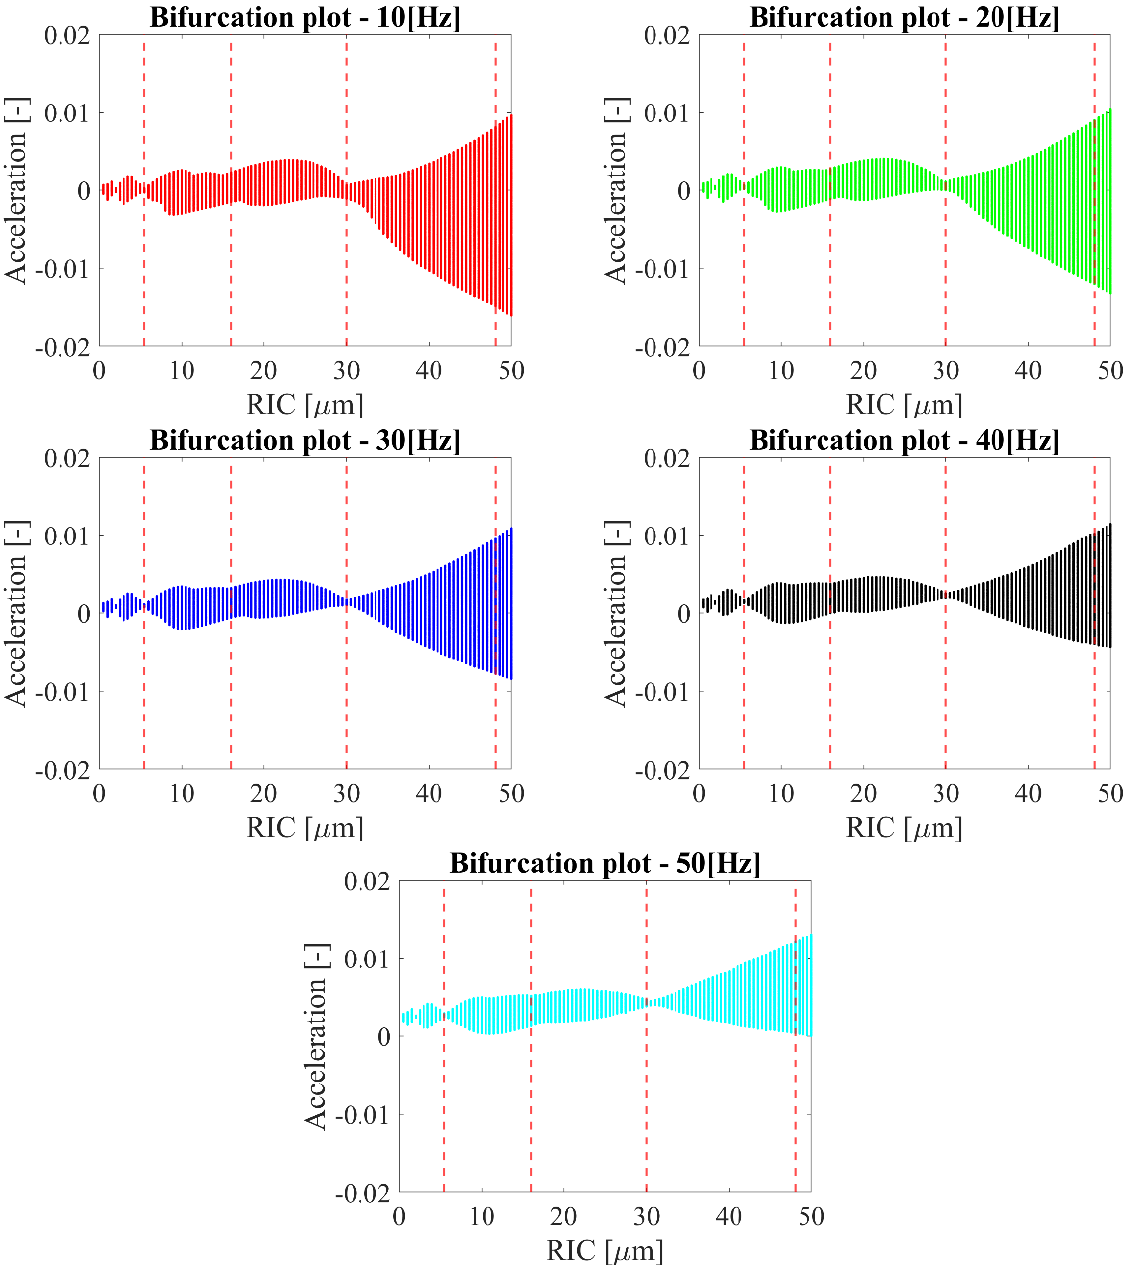
Figure 4. Bifurcation diagrams for different rotational velocities considering during the test.